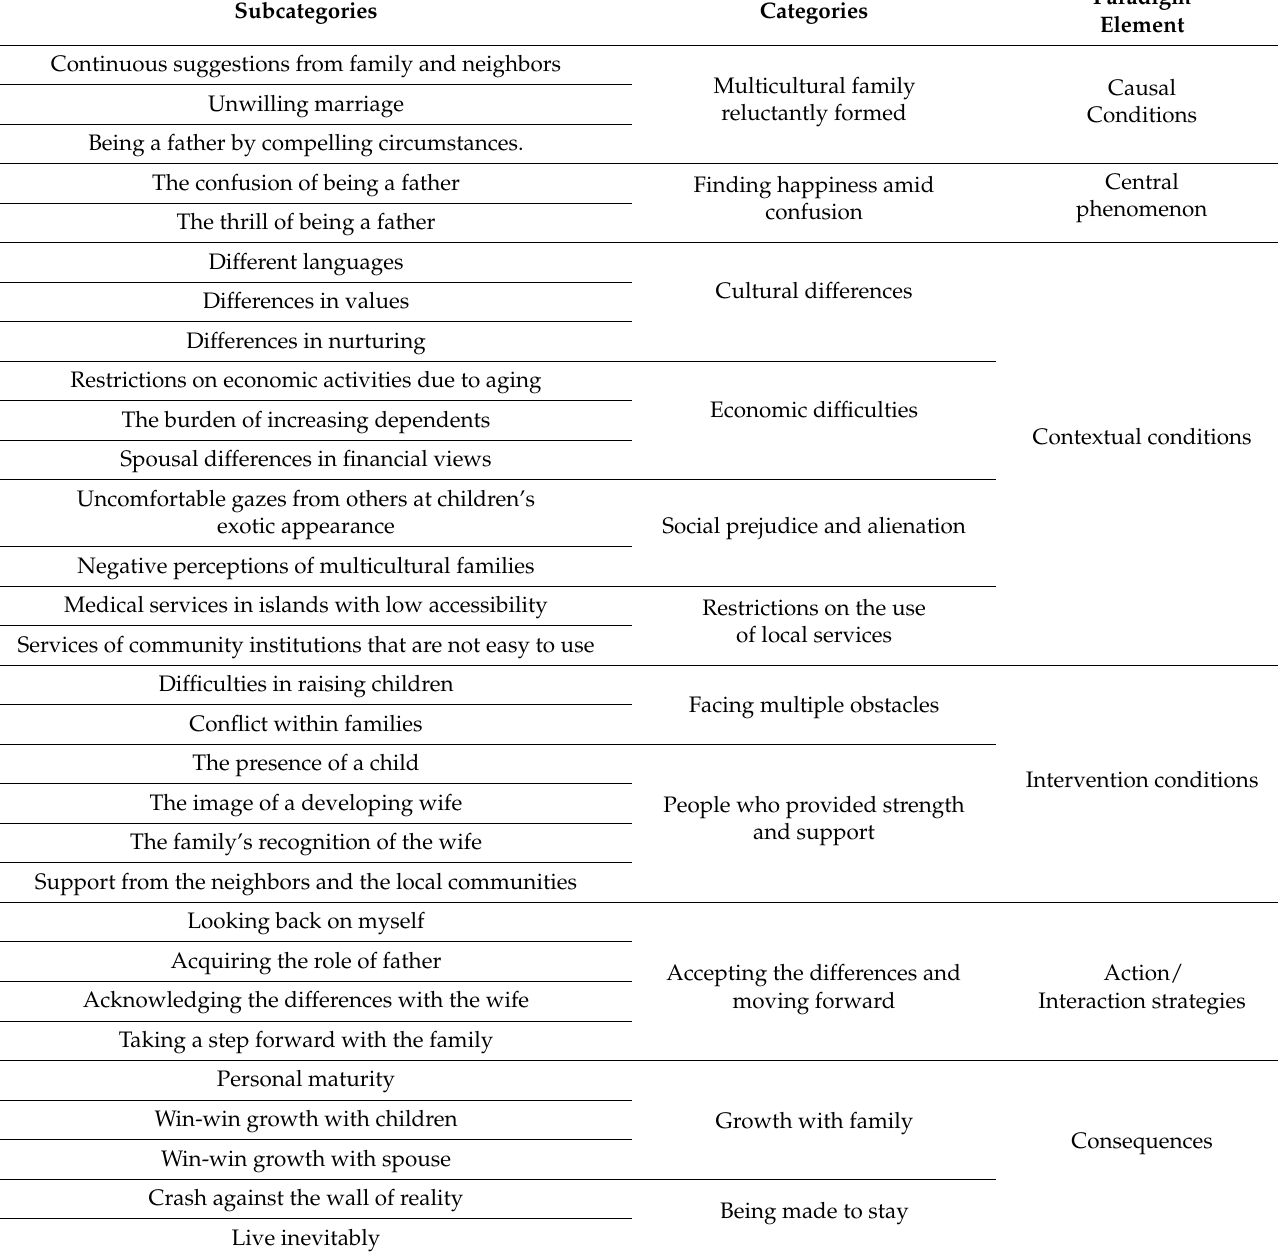
Table 2. Paradigm, categories, and subcategories of the adaptation process of Korean fathers within multicultural families in Korea.